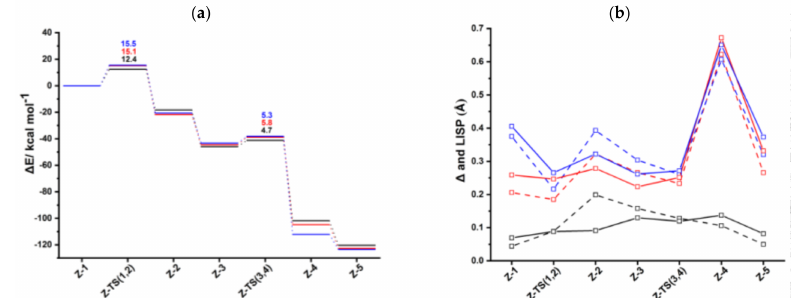
Figure 2. ( a ) Energy profiles of acetylene [2 + 2 + 2] cycloaddition to benzene catalyzed by CpRh (black), IndRh (red), and bimetallic anti-IndRh (blue) (Scheme 3a, Path I). ( b ) Profiles of the slippage parameters ∆ (dashed line) and LISP (solid line) for the acetylene [2 + 2 + 2] cycloaddition cycles catalyzed by CpRh (black), IndRh (red), and bimetallic anti-IndRh (blue) along Path I (Scheme 3a). Level of theory: ZORA-BLYP / TZ2P.